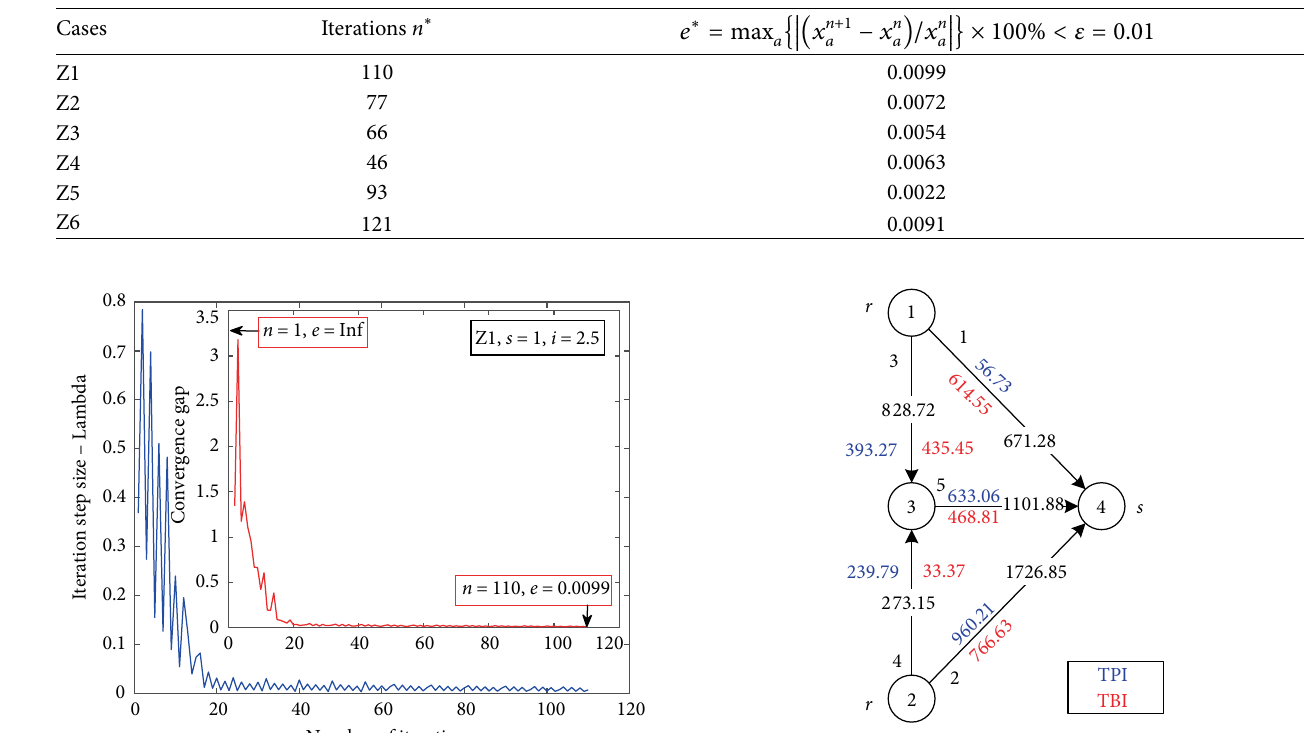
Figure 3: Optimal solutions of traffic assignment in case Z1 ( 푖 1 = 2.5